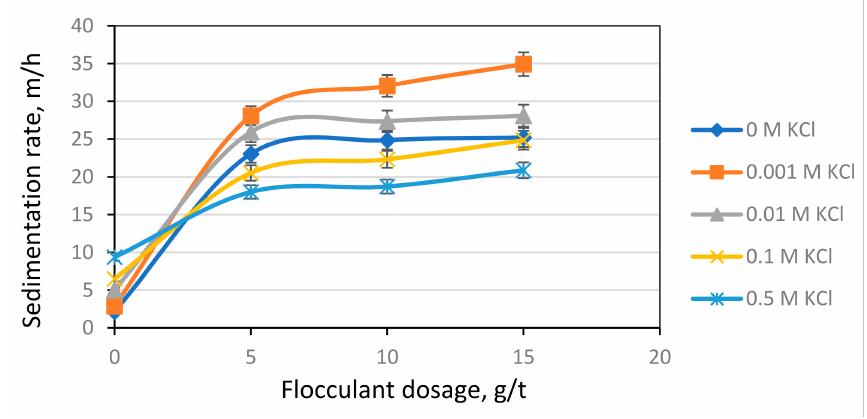
Figure 6. Sedimentation rate in relation to the flocculant dose Magnafloc-338 in deionized